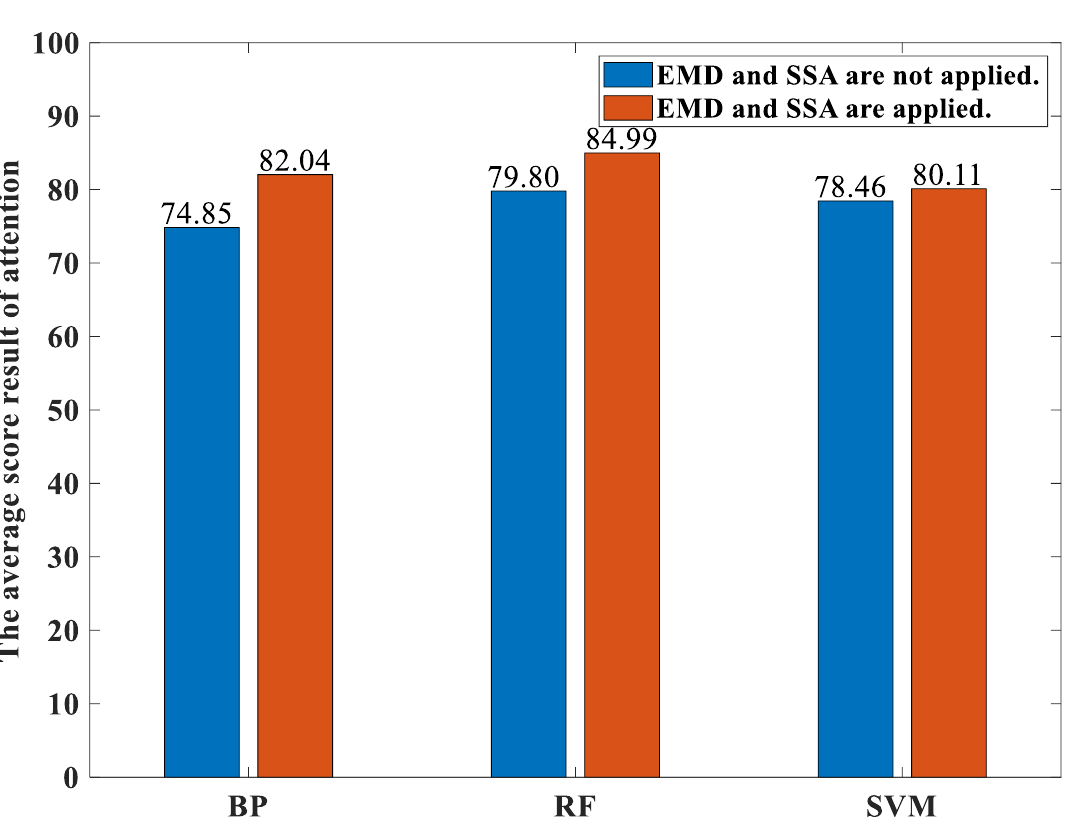
Figure 11. The average percentages of the classification accuracies over both these 12 participants performing the various activities yielded by both our proposed method and the traditional methods with different classifiers under the concentration state. Table 9. The percentages of the classification accuracies yielded by our proposed method via the various classifiers based on the EEGs at different durations of the samples acquired from Hejian performing the reading activity under the concentration